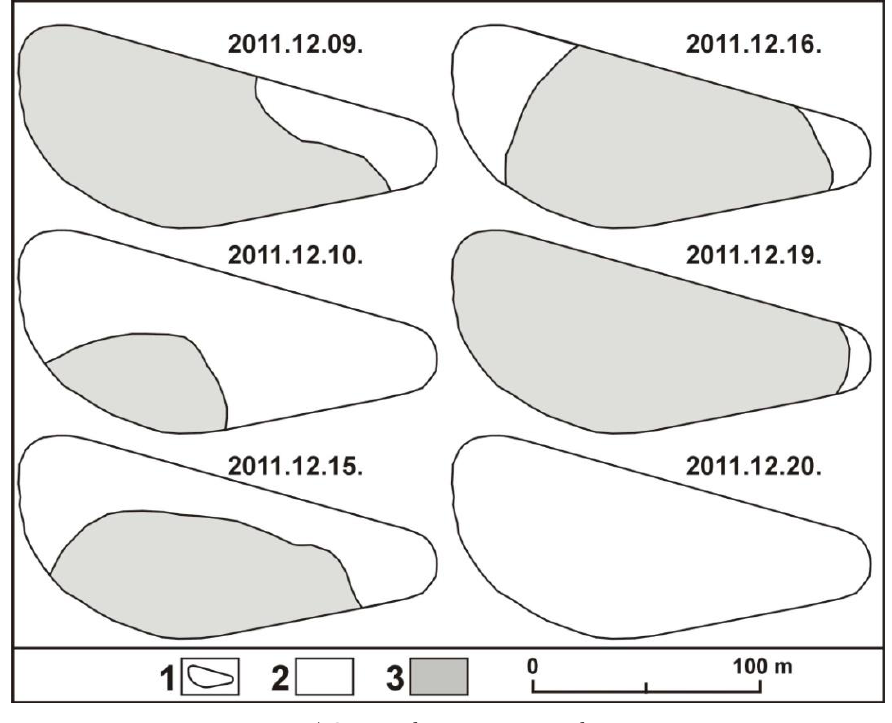
Fig. 5. Stages of water reservoir